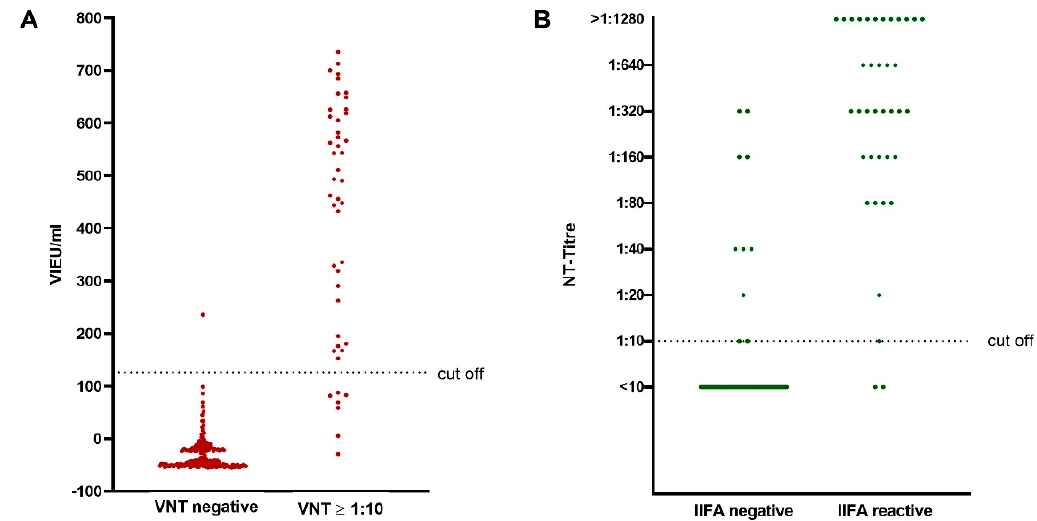
Figure 1. Distribution of ( A ) Vienna units (VIEU)/mL determined by ELISA within negative and positive neutralization test (NT) results and ( B ) of NT-titers within negative and positive IIFA results.